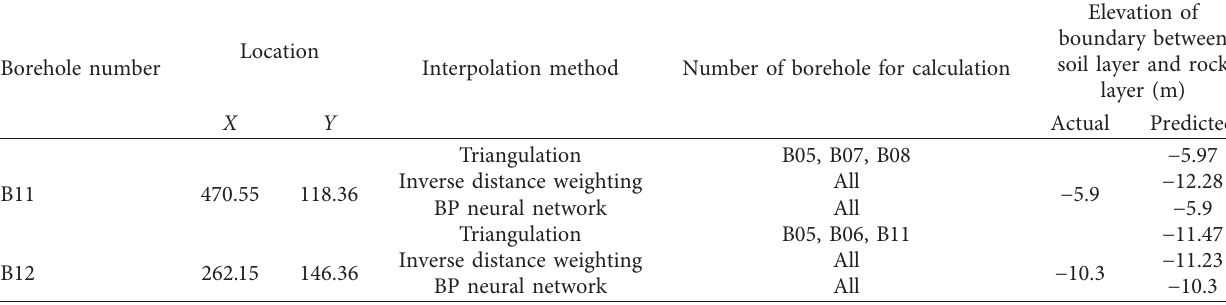
Table 2: Comparison of the 3 interpolation